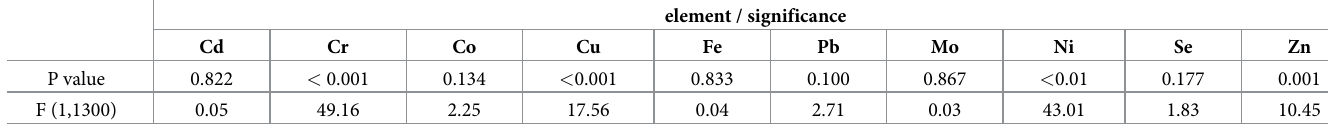
Table 5. Results of linear regression for elements with